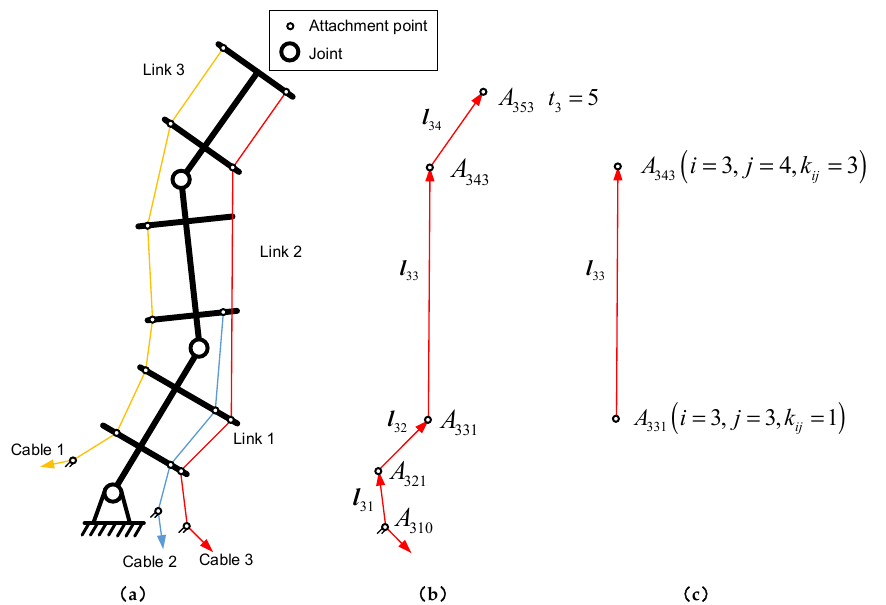
Figure 2. Arrangements of a three-DOF three-cable CDSM’s cable system, single cable, and single segment in the system; ( a ) The arrangements of a three-DOF three-cable CDSM system; ( b ) Cable 3 of the CDSM; ( c ) The third segment of cable 3.